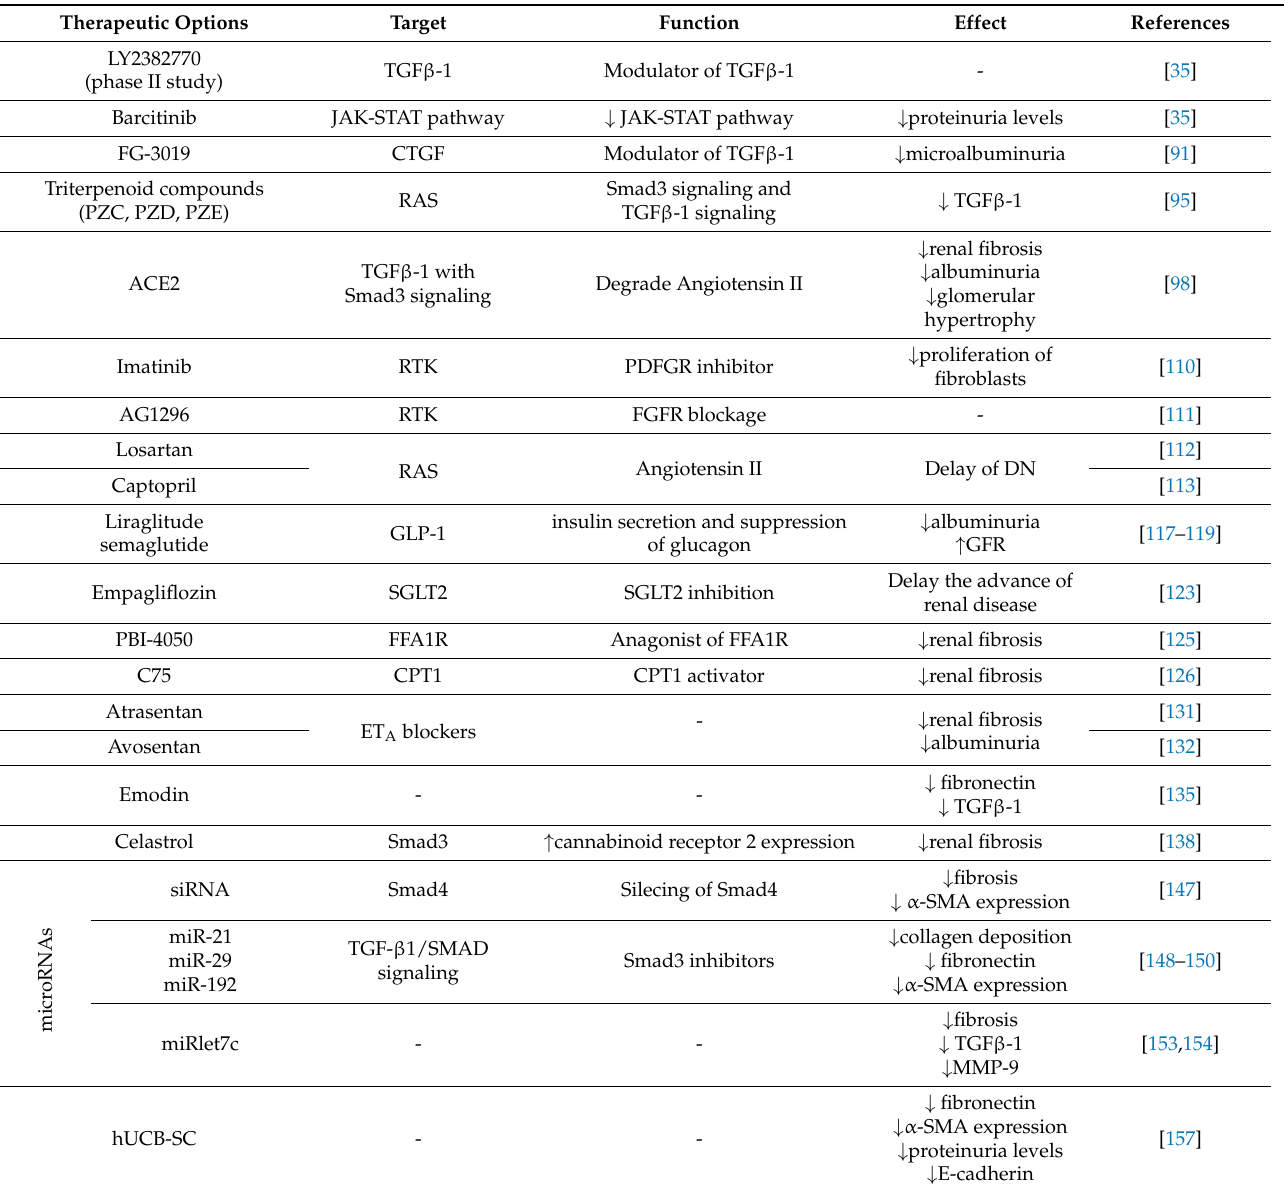
Table 1. Therapeutic options available to delay kidney